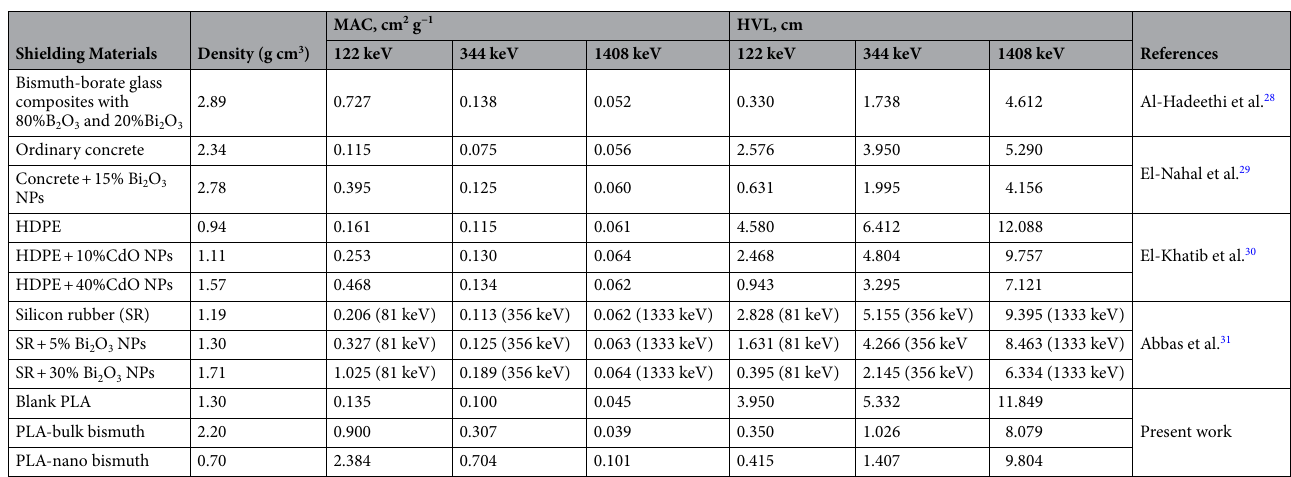
Table 4. Comparison of the present work with other previously reported shielding